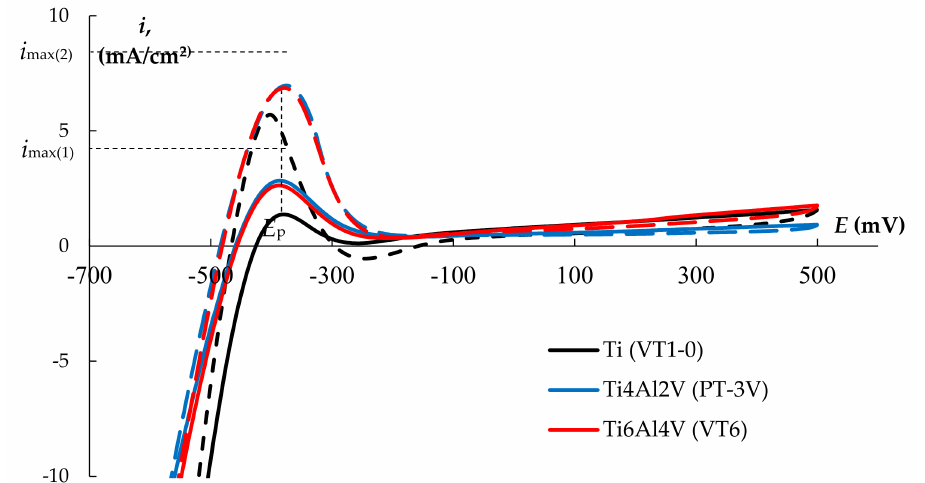
Figure 11. Potentiometric dependencies i ( E ) for the Ti alloys’ specimens obtained by SPS. Solid lines—ascending potential (passivation), dashed lines—descending potential (reactivation). Black curves—Ti, blue curves—Ti5Al2V alloy, red curves—Ti6Al4V alloy. Data for Zone 1 (central parts of the specimens).